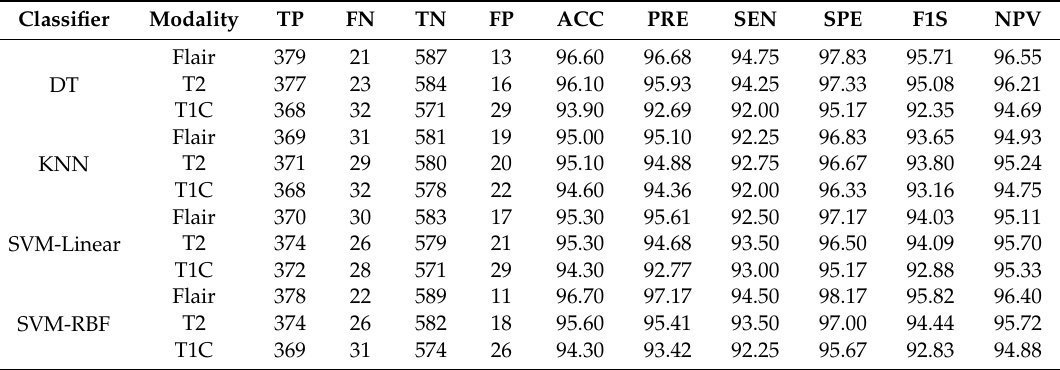
Table 3. Performance values obtained with VGG19 with chosen